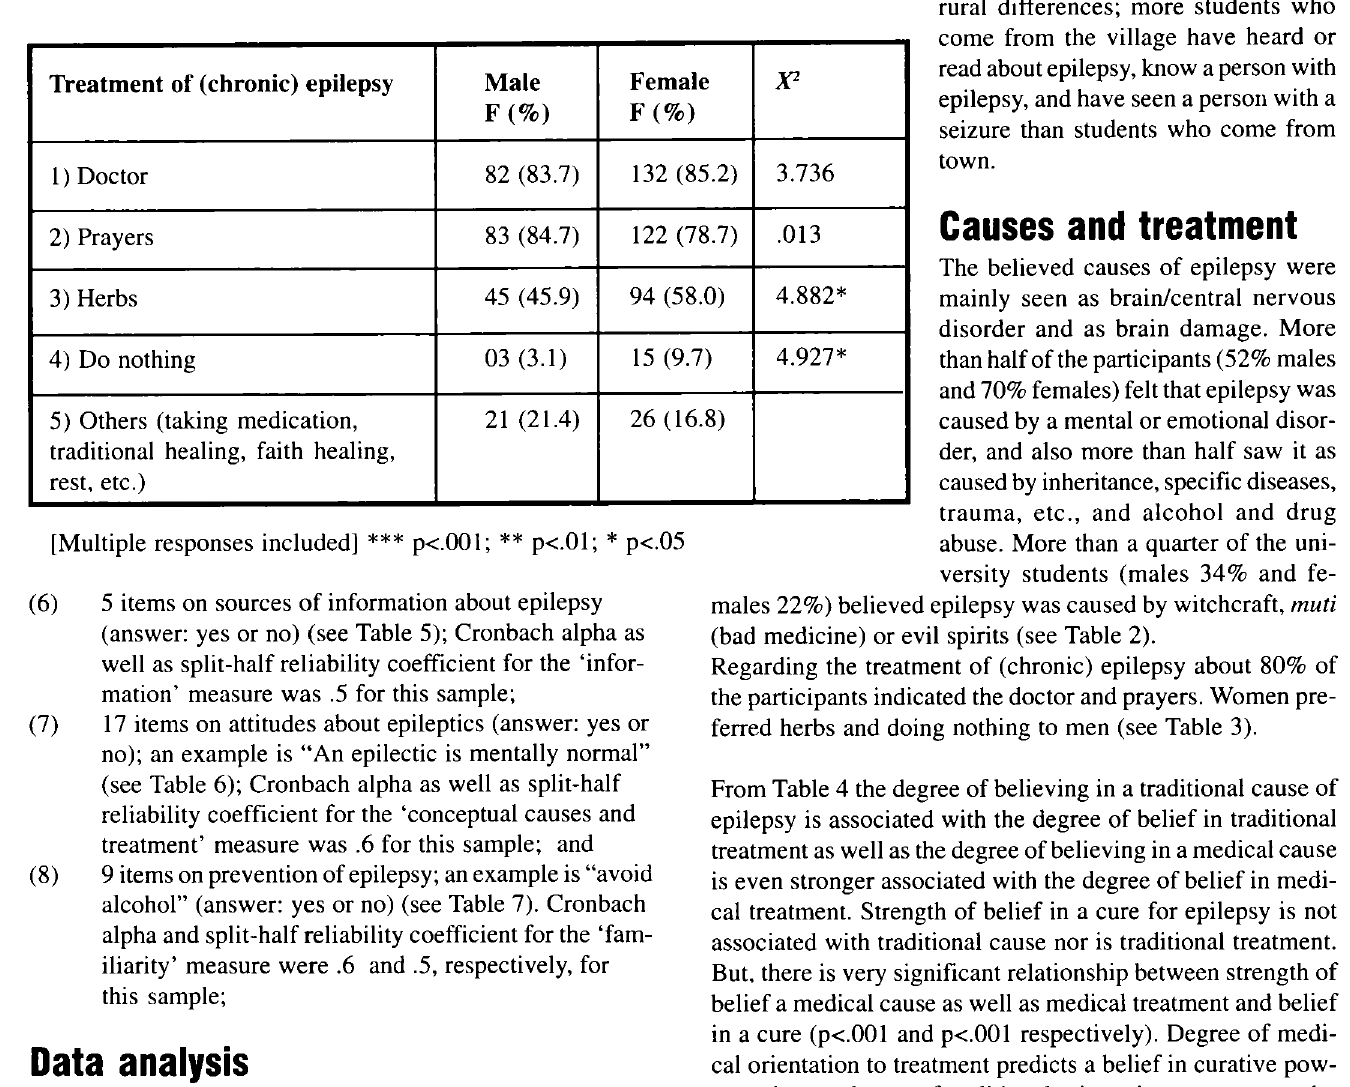
Table 3: Treatment of (chronic) epilepsy